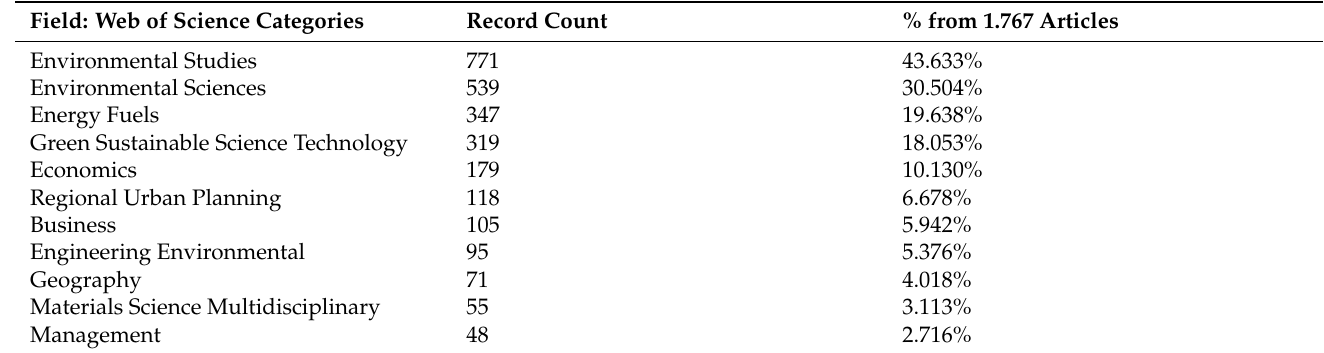
Table 2. Top 11 record count publications based on WoS Categories, for the couple: